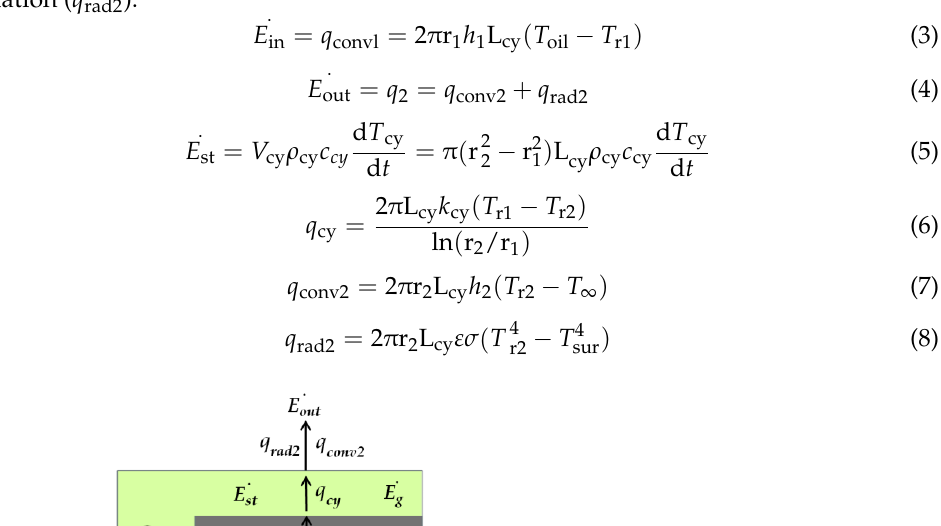
radiation ( q rad2 ).